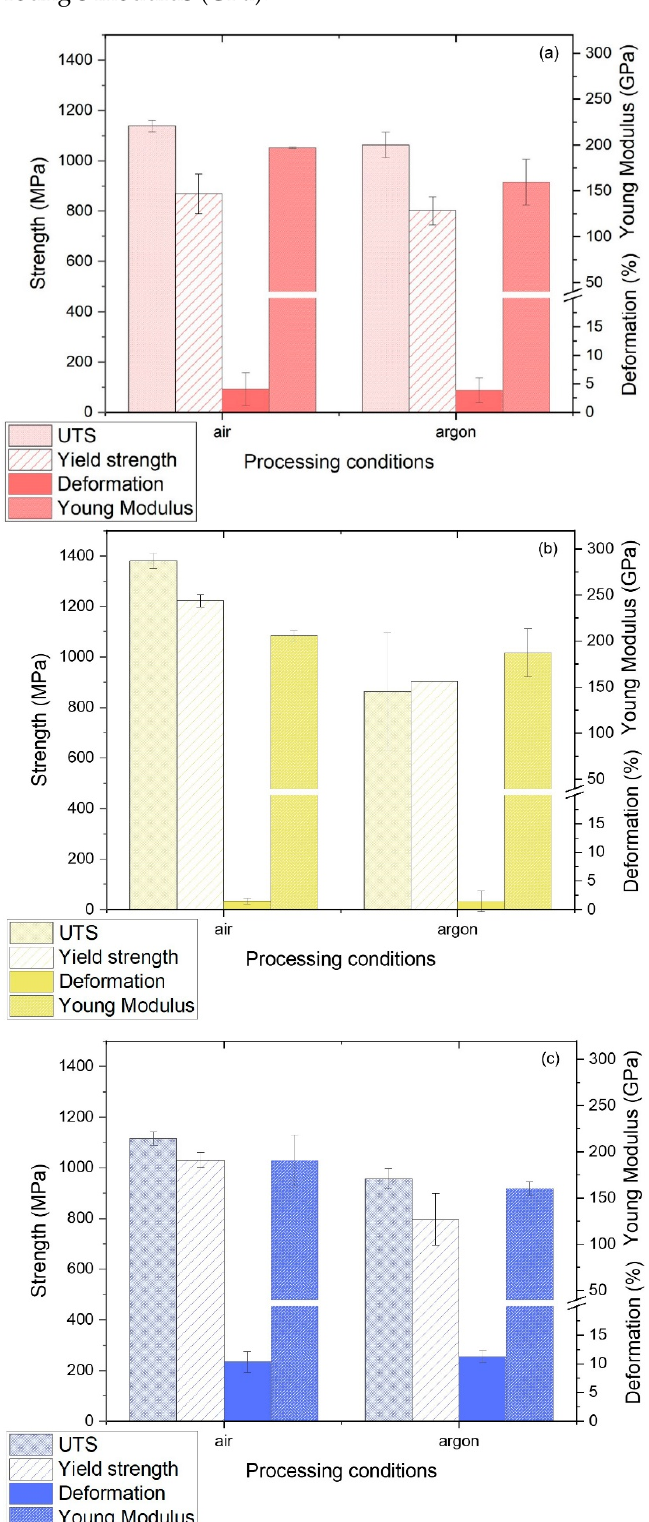
Figure 6. Mechanical property values of specimens manufactured in air and in an argon atmosphere: ( a ) as-built specimen; ( b ) after TT1 treatment; and ( c ) after TT2 treatment. ( a ) as-built specimen; ( b ) after TT1 treatment; and ( c ) after TT2